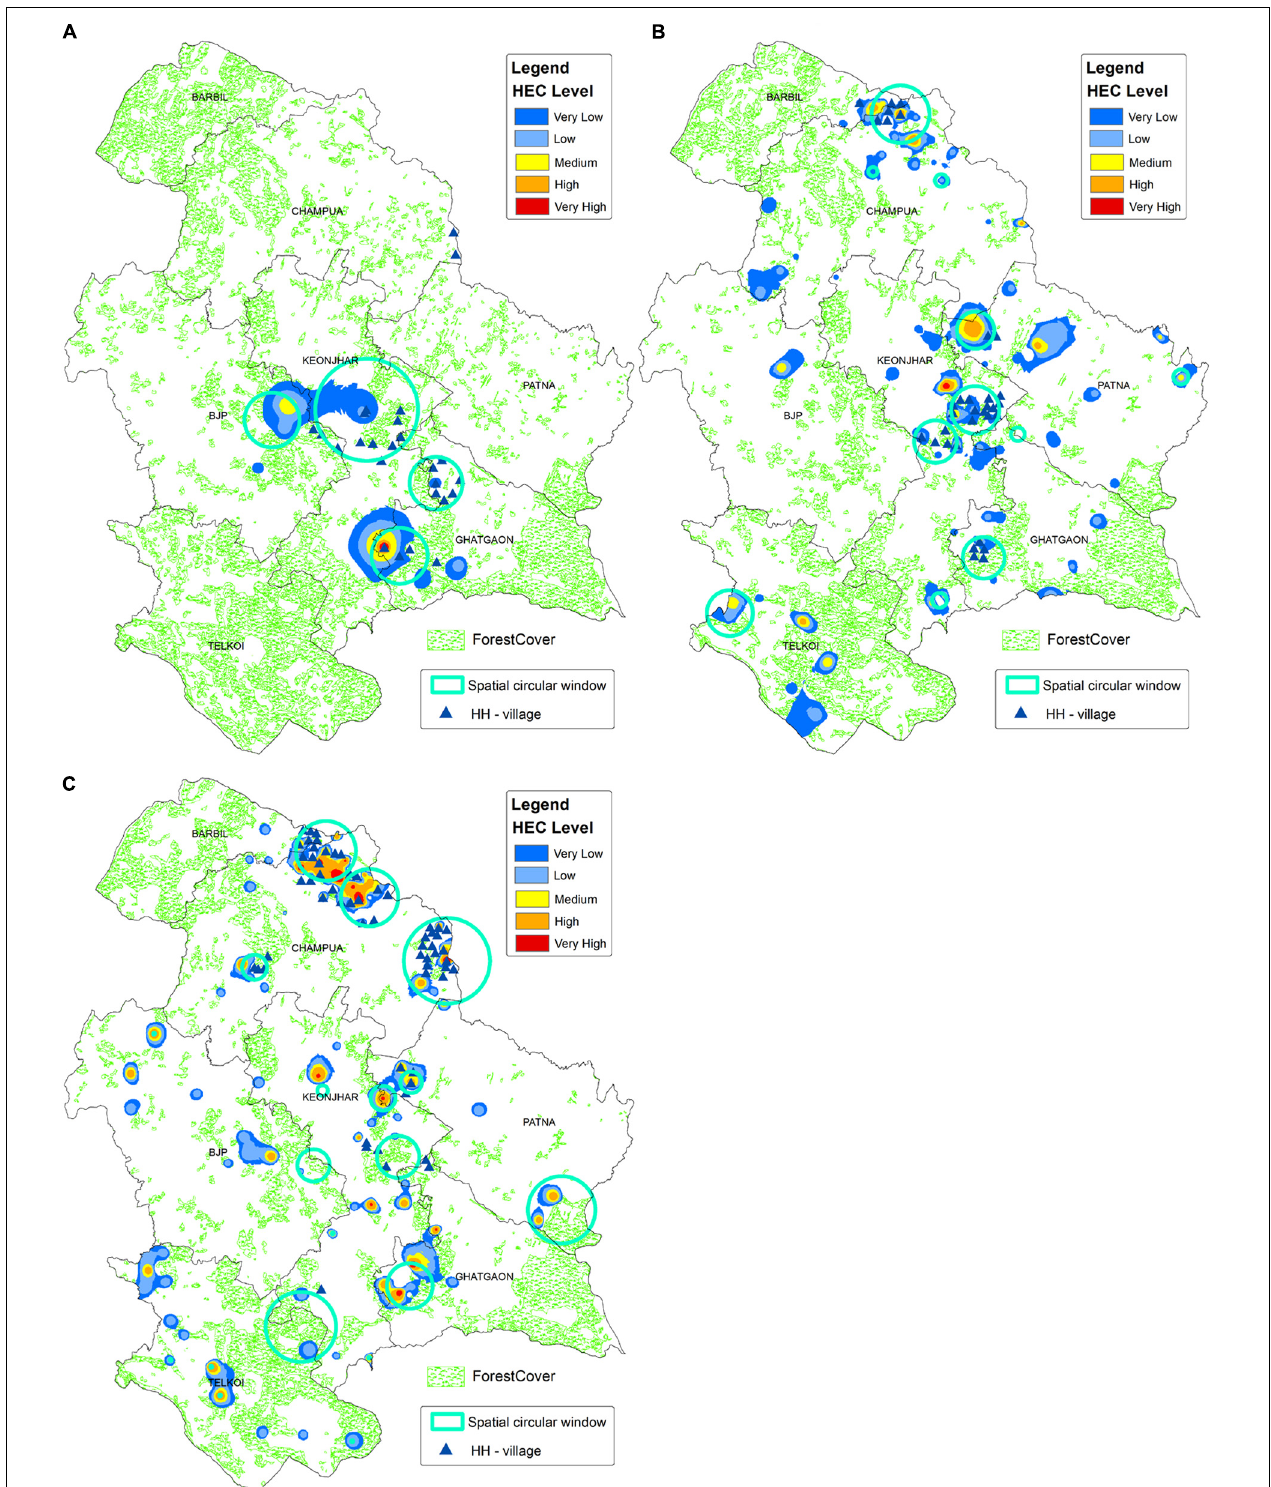
FIGURE 7 | The descriptive map showing the regions highly affected by HEC, which was generated by overlaying high-high HEC and SCWs over kernel density map, for (A) HEC1, (B) HEC2, and (C) HEC3. The kernel density layer is showing the smooth surface map of HEC cases, where the shades of red regions have the highest density of HEC cases. Forest cover data for 2006 (A) , 2012 (B) , and 2018 (C) is given in the background, which is showing a decreasing trend in forest cover from HEC1 to HEC3.